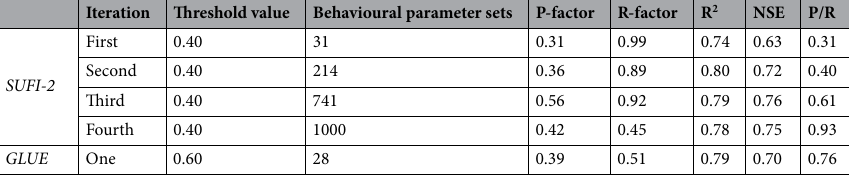
Table 6. The statistic summary of the simulation results of each iteration using